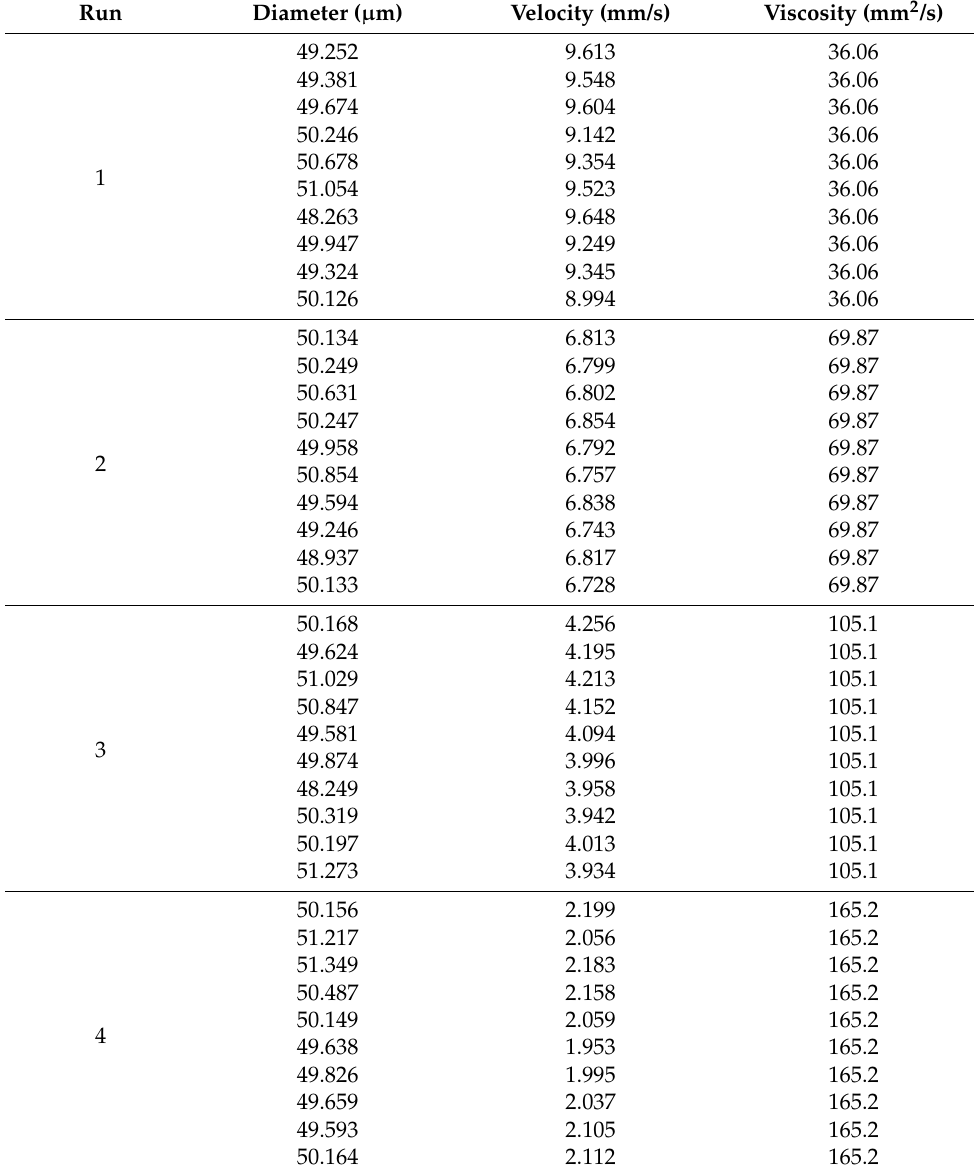
Table 4. Experimental data of particles move at different velocities in different